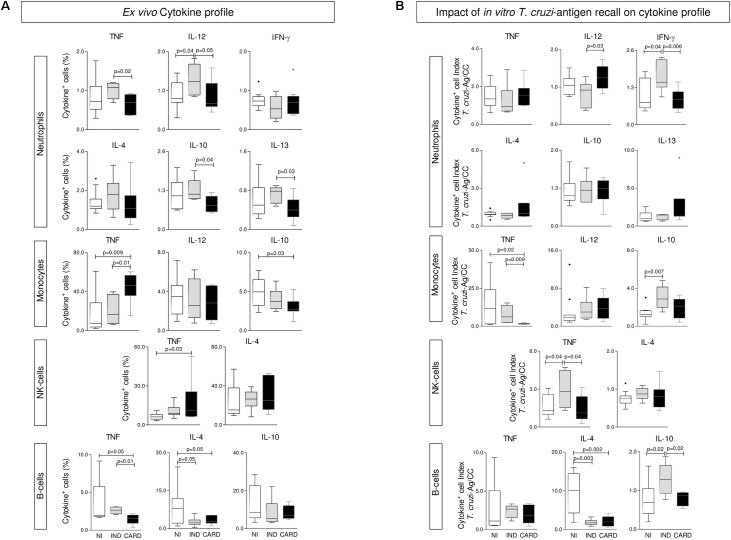
Cytokine profile of phagocytes, NK-cells, and B-lymphocytes. The analysis of cytokine pattern produced by neutrophils, monocytes, NK-cells, and B-cells were performed in whole blood samples collected from indeterminate (IND,  = 8) and cardiac (CARD,  = 13) Chagas disease patients and non-infected subjects (NI,  = 11). Pro-inflammatory/regulatory cytokines (TNF, IL-12, IFN-γ, IL-4, IL-10, and IL-13) were measured at ex vivo
(A) and upon T. cruzi-antigen recall in vitro
(B). Data are displayed in box plot format (median with minimum and maximum values) as percentage of cytokine+ events for each cell population. Significant differences at p < 0.05 are underscored by connecting lines and p-values provided in the figure.